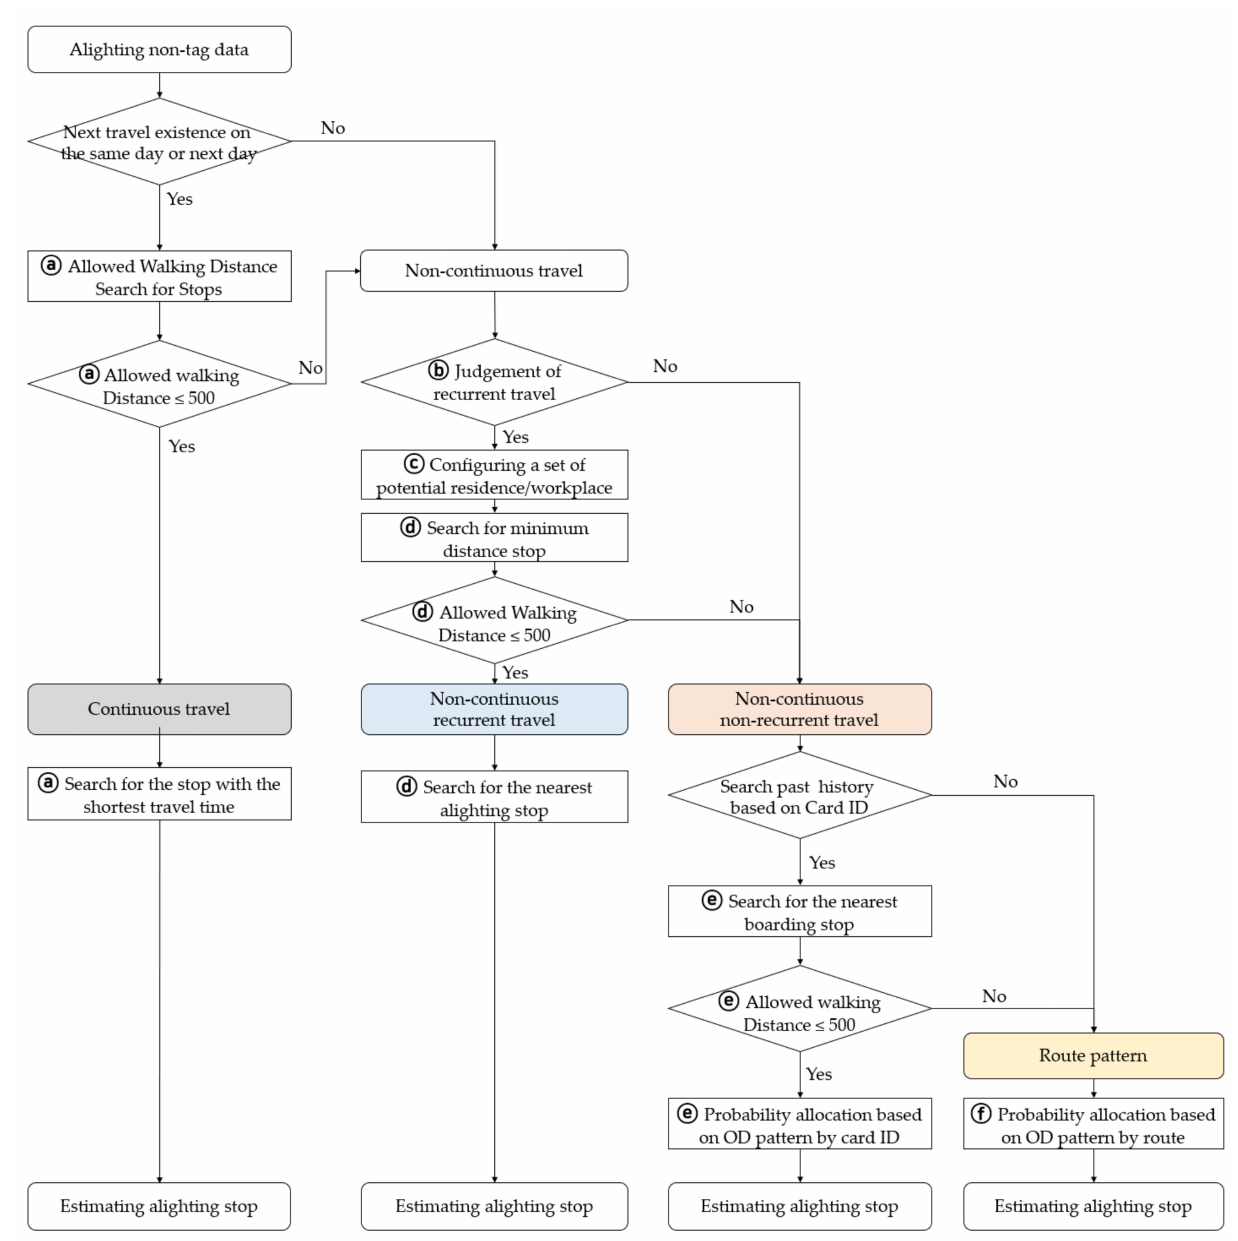
Figure 1. Method of gradually estimating destination of bus trip considering trip type characteristics: ⓐ Judgment of continuous travel, ⓑ Judgment of recurrent travel, ⓒ Configuring a set of potential residences/workplaces, ⓓ Judg- ment of non-continuous recurrent travel, ⓔ Judgment of non-continuous non-recurrent travel, ⓕ Route pattern .